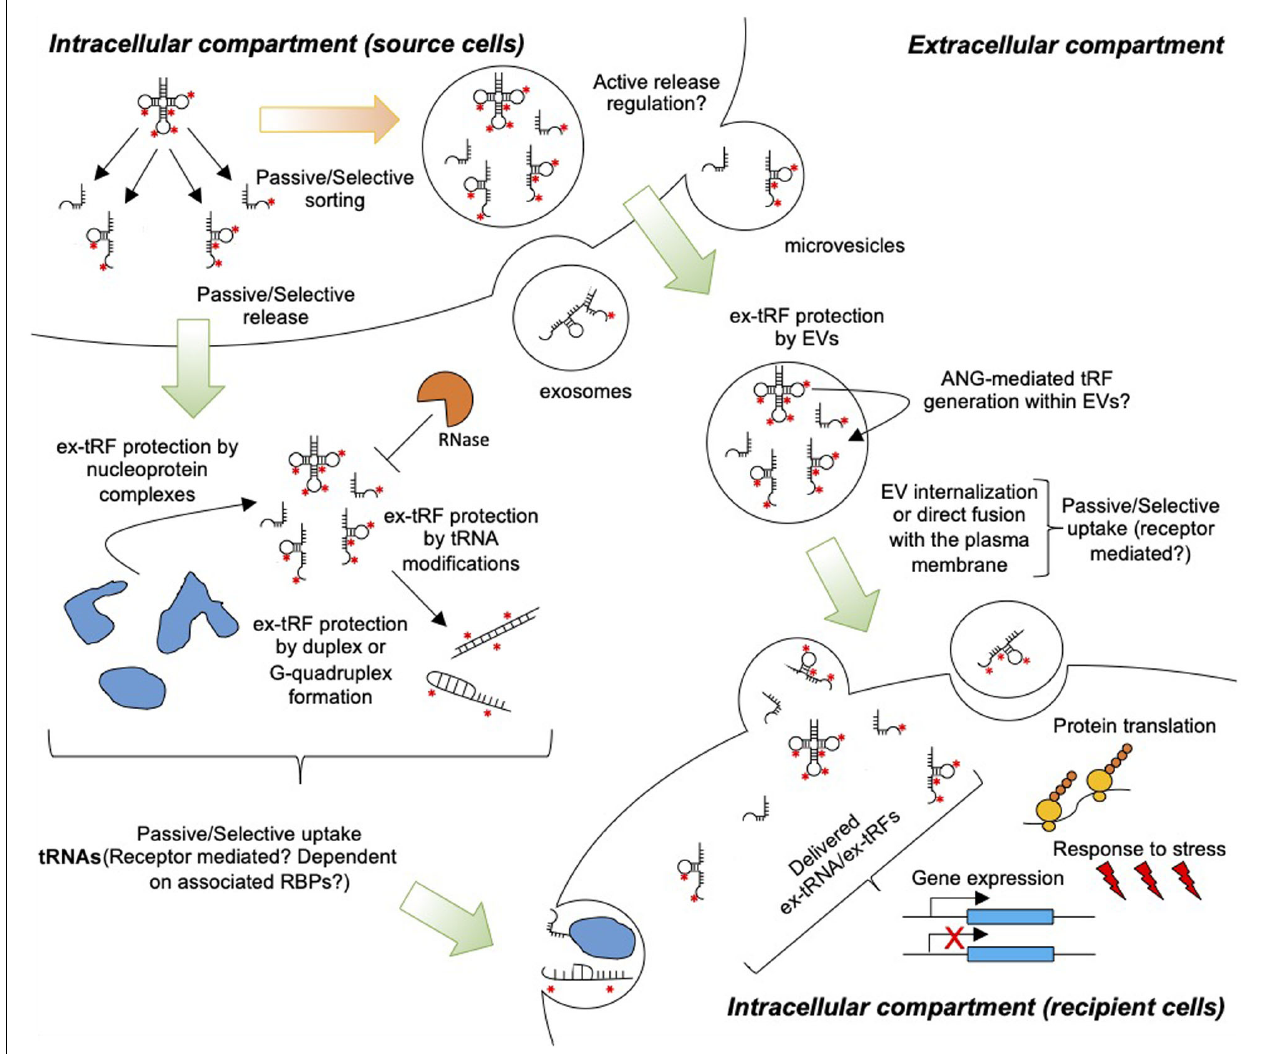
FIGURE 1 | Extracellular tRNA and tRFs in cell-to-cell communication. tRNAs and tRFs are passively or selectively loaded into EVs and released to the extracellular space. Additionally, cells release ex-tRNAs/ex-tRFs that are not associated with EVs, but these species may be protected from degradation by RNases through the formation of secondary structures, G-quadruplexes, and/or ribonucleoprotein complexes. Red asterisks indicate modified nucleotides in tRNAs. Uptake by target cells may occur through the direct fusion of EVs with the plasma membrane, non-specific endocytosis, or receptor-mediated endocytosis. Naked ex-tRNA/ex-tRFs can also be passively or selectively captured by cells. Inside cells ex-tRNAs/ex-tRFs may influence gene expression and/or protein translation, modulating stress and immune